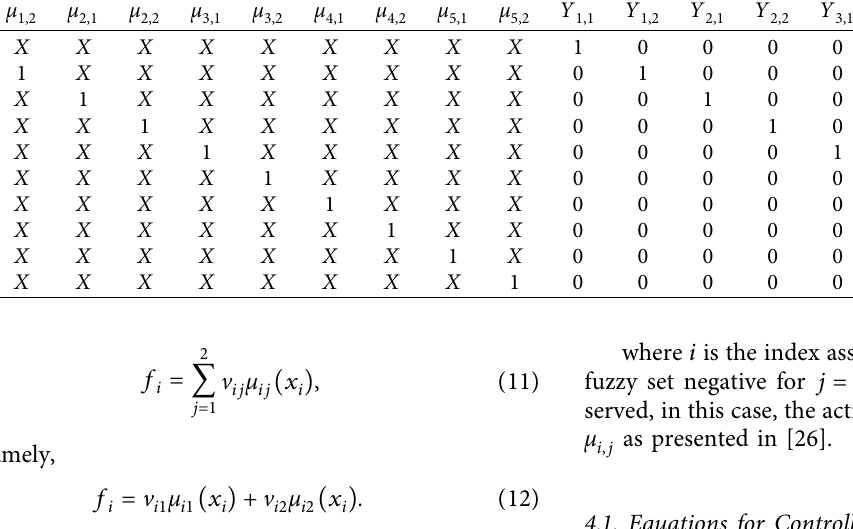
Table 2: Rules associated with the structure of the neuro-fuzzy system used for